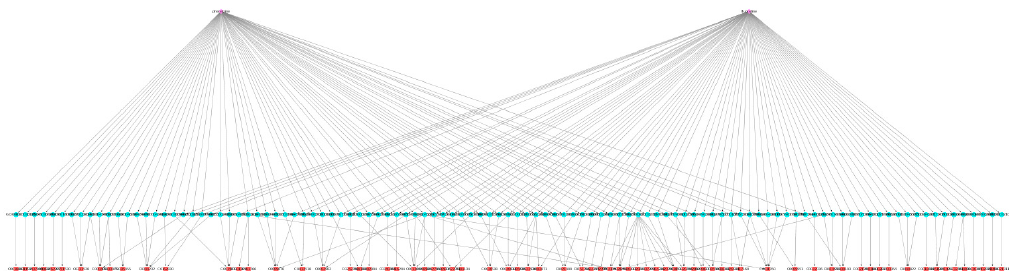
Figure 7. Fluoxetine–phenelzine drug combination network visualization. This is a visualization of the subgraph containing the GO terms and ADRs associated with fluoxetine and phenelzine, two drugs that, in combination, may produce serotonin syndrome. The two drugs are represented by purple diamonds, the 107 GO terms as blue circles, and the 72 ADRs as red